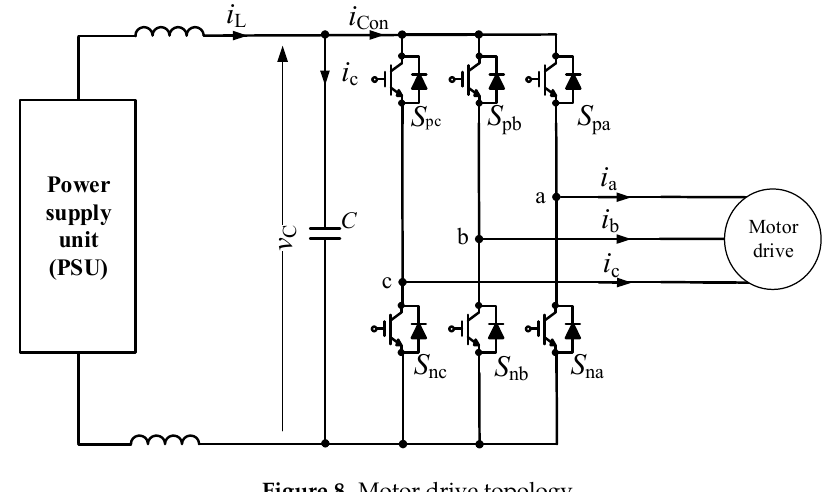
Figure 8. Motor drive topology.